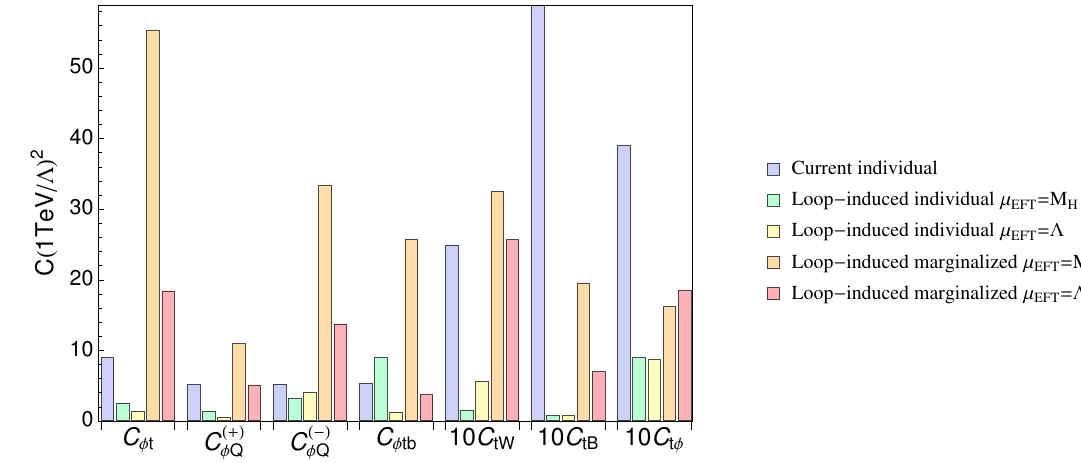
Figure 7 . Individual and marginalised sensitivities (i.e. one-half of 95% CL interval) at HL-LHC through top loops, including di(cid:11)erential measurements, compared with current individual limits. (cid:22) EFT is set at either M H = 125 GeV or (cid:3) = 1